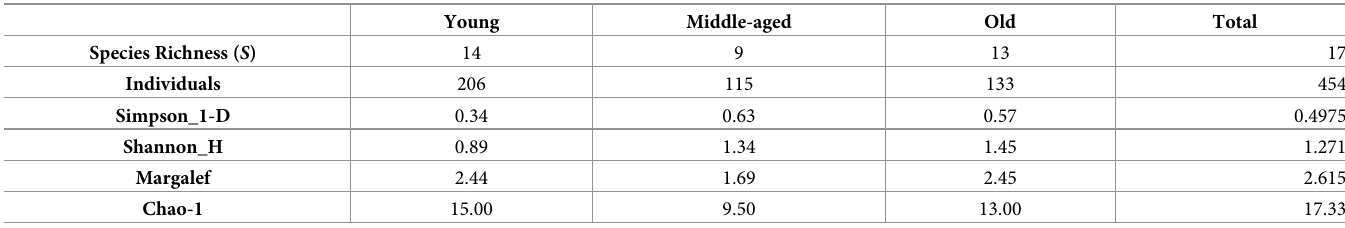
Table 2. Diversity indices by the altitudinal range and in